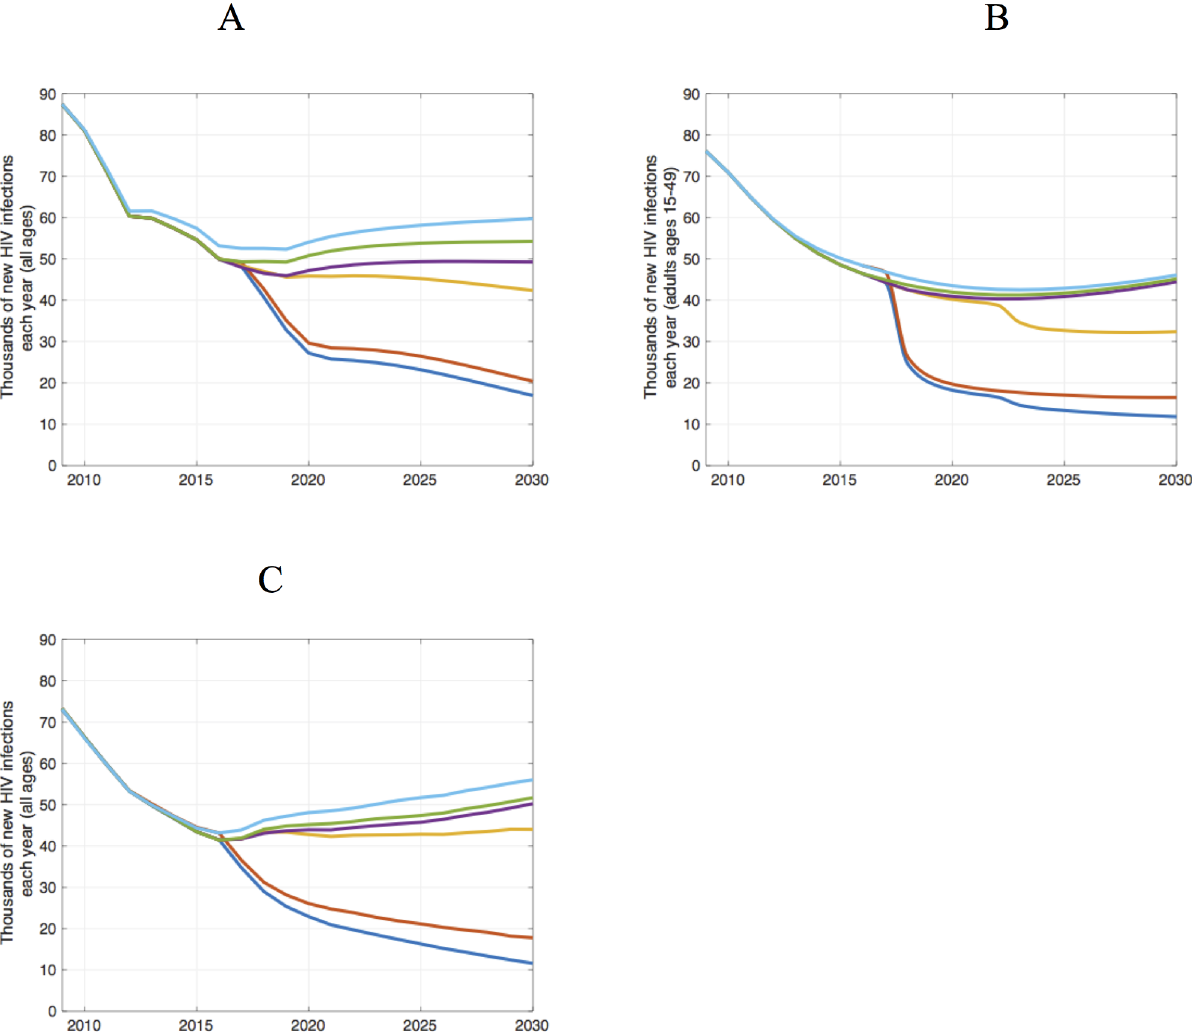
Fig 2. Number of new HIV infections each year over 2009–2030 by scenario, produced by the (A) Goals, (B) ICL, and (C) EMOD models. The scenarios shown are: the counterfactual of no VMMC ever (turquoise), the VMMC program ends after 2016 (green), the VMMC program ends after 2018/19 (purple), the program targets through 2021 are met and maintained in a ’status quo’ context (yellow), Fast Track targets are achieved without VMMC (red), and the VMMC program targets are achieved in a Fast Track context (blue). Infections are among all ages in the Goals and EMOD models (A and C, respectively) and among ages 15–49 in the ICL model